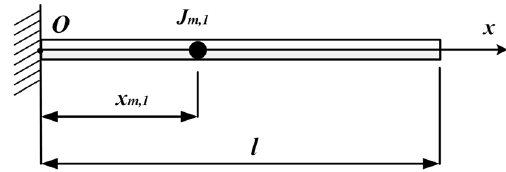
Figure 4. The cantilevered shaft carrying single rotary inertia.